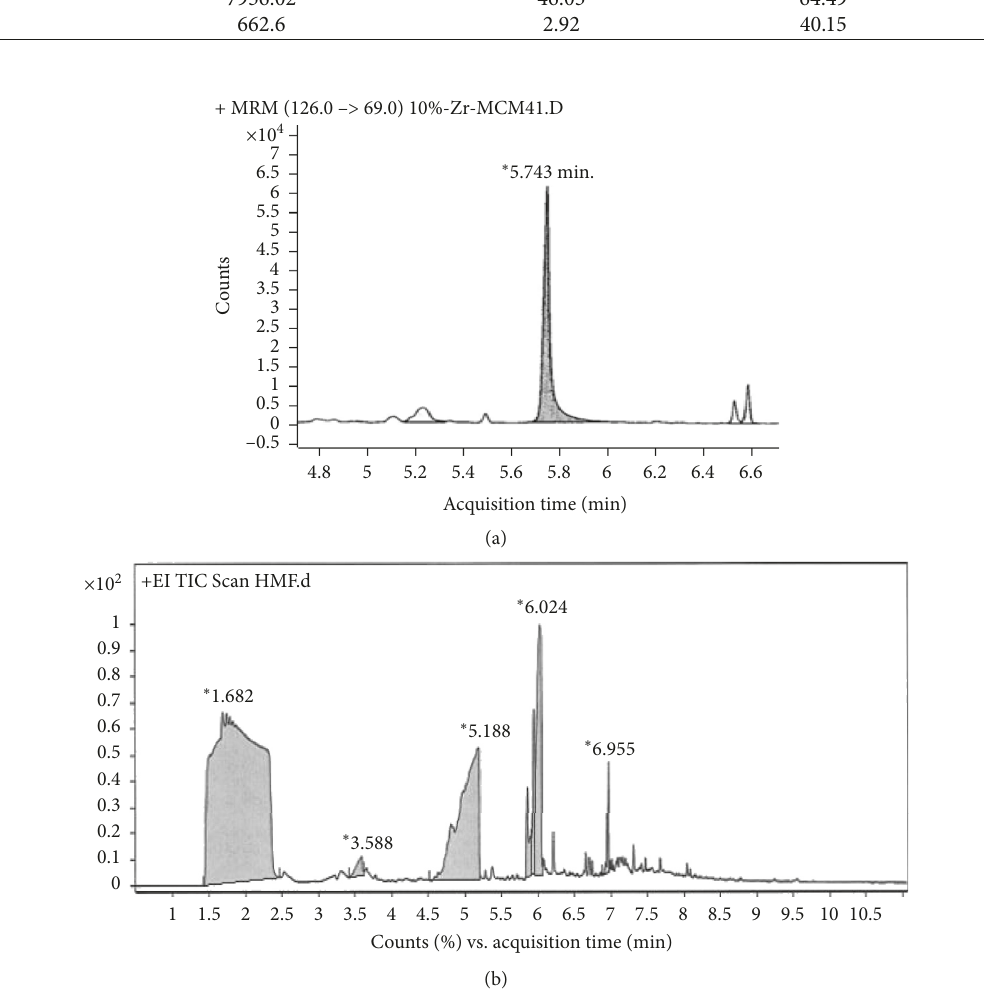
Figure 6: 5-HMF (a) and by-products (b) in the cellulose conversion over Al-incorporated SBA-15